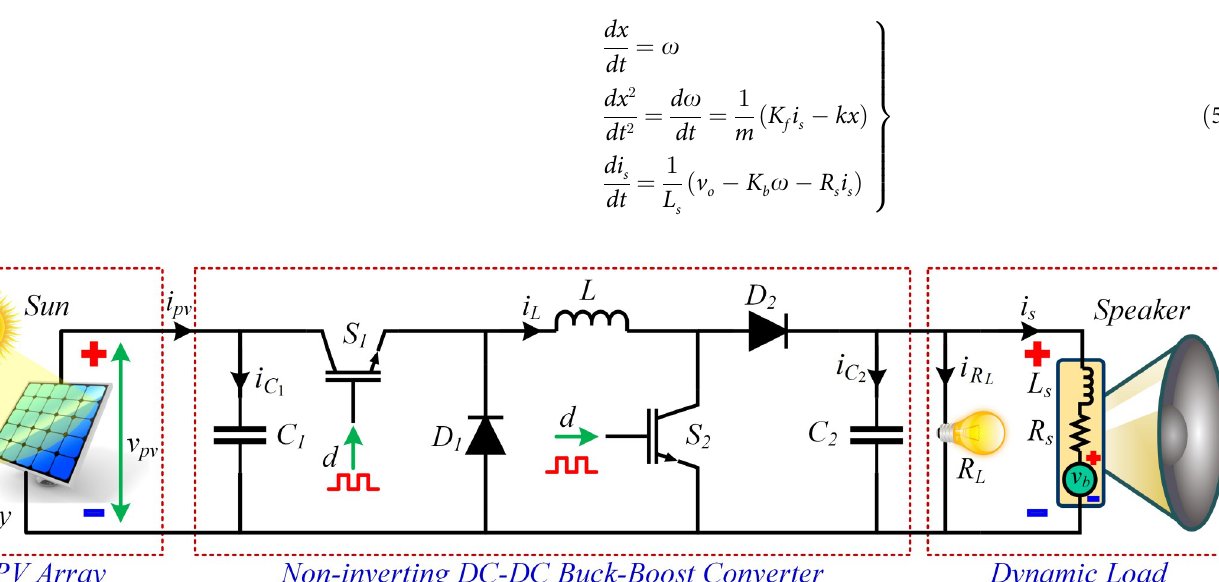
Fig 8. Equivalent circuit diagram of the NIBB DC-DC converter with source (standalone PV array) and dynamic load.